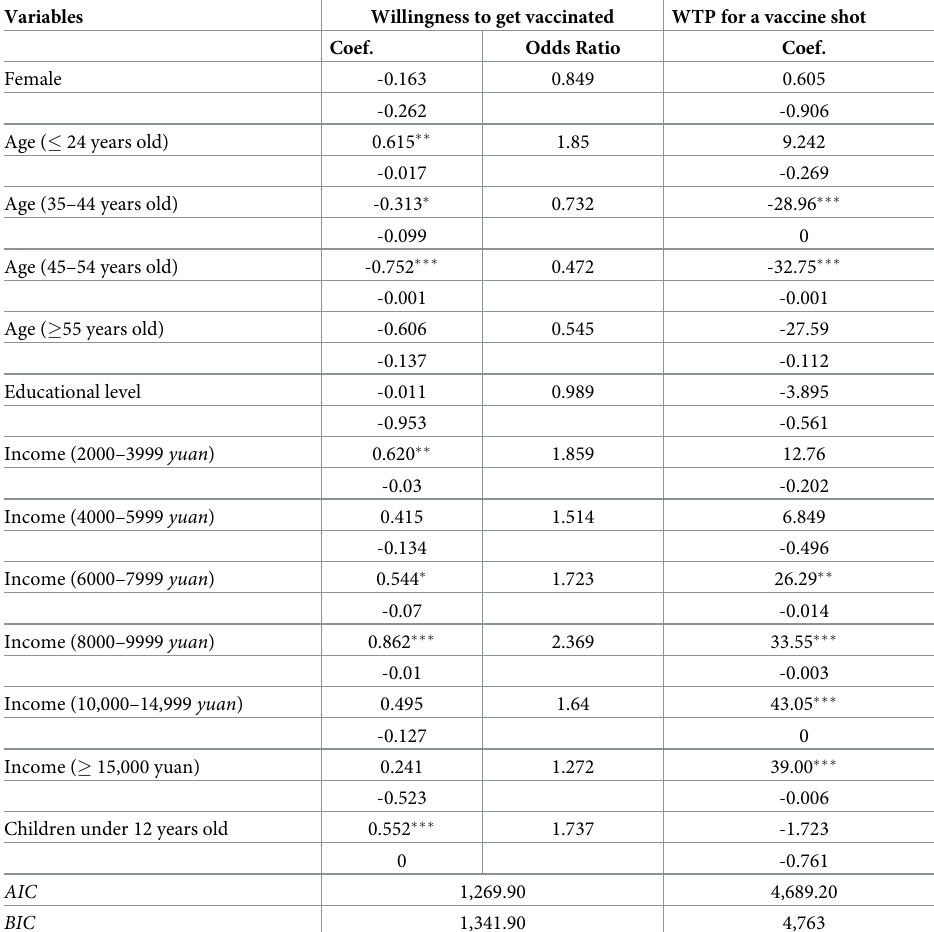
Table 3. Regression